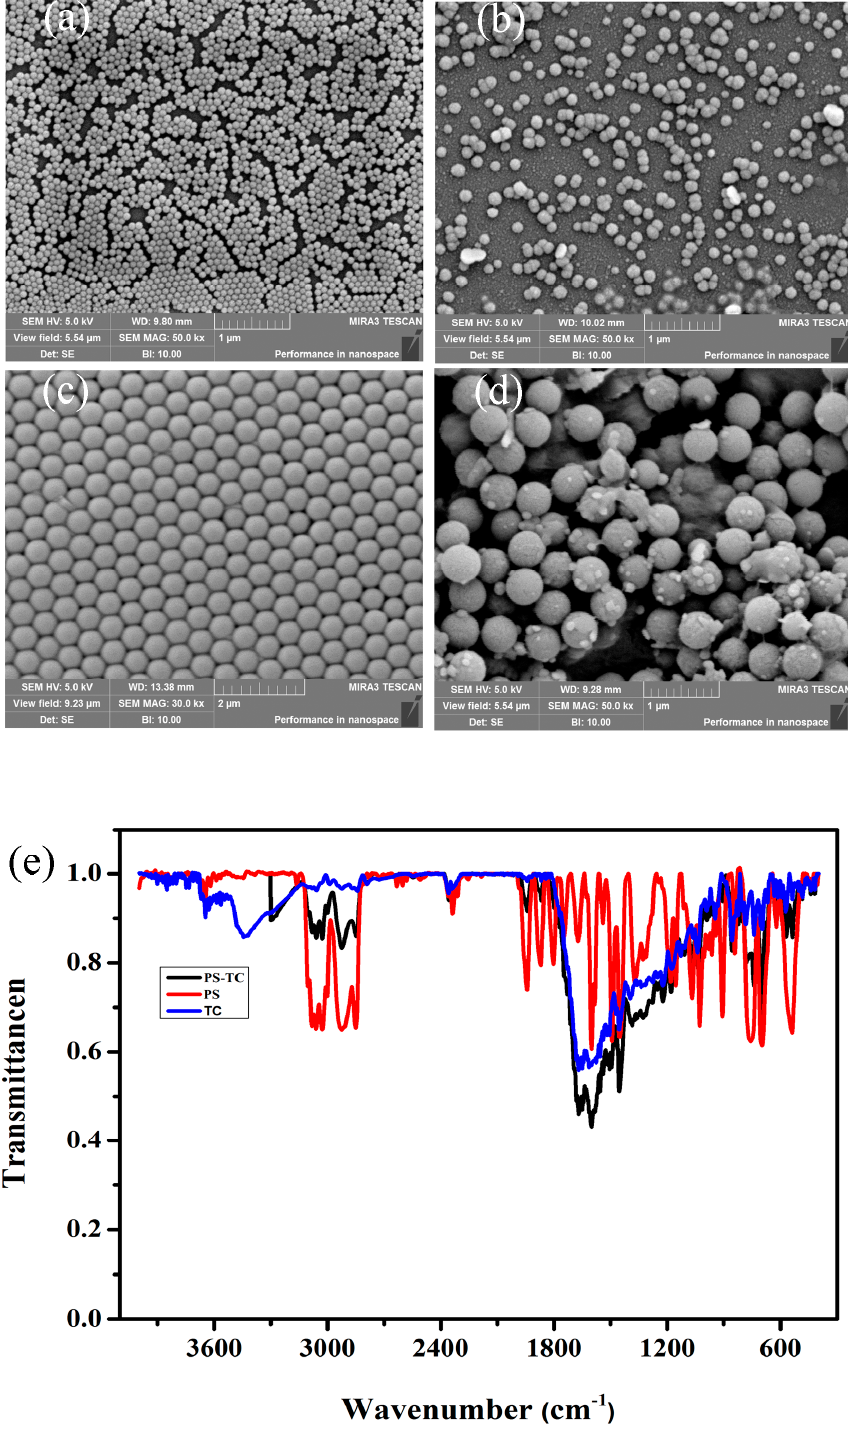
Figure 2. The characteristics of polystyrene spheres (PS). ( a ) 60 nm PS-NPs; ( b ) 60 nm PS-NPs in medium; ( c ) 500 nm PS-MPs; ( d ) 500 nm PS-MPs in medium; ( e ) Fourier transform infrared spectroscopy of PS and PS compound TC (PS-TC). Table 1. The hydrated sizes of PS-NPs and PS-MPs.